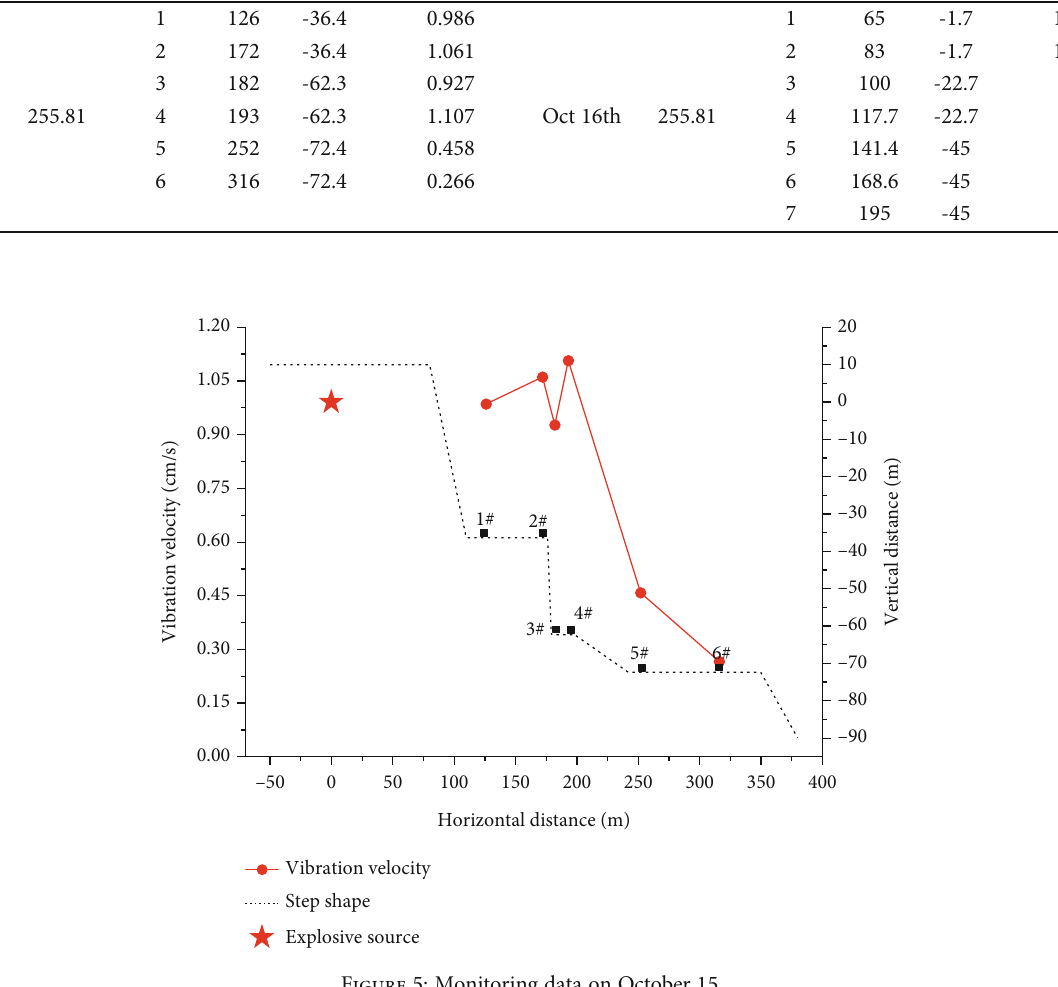
Figure 5: Monitoring data on October